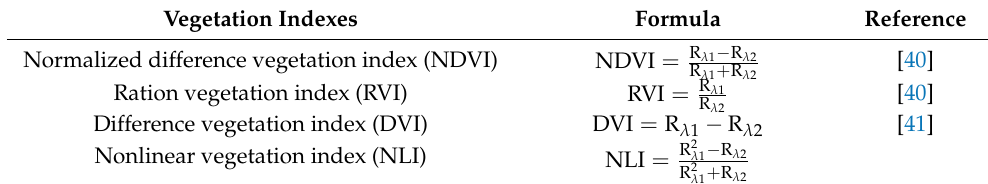
Table 3. Vegetation indices tested in this study. Vegetation Indexes Formula Reference Normalized difference vegetation index